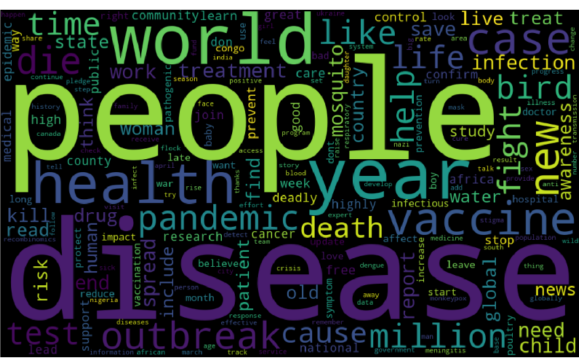
Figure 3. Word cloud once removed keywords about viruses.